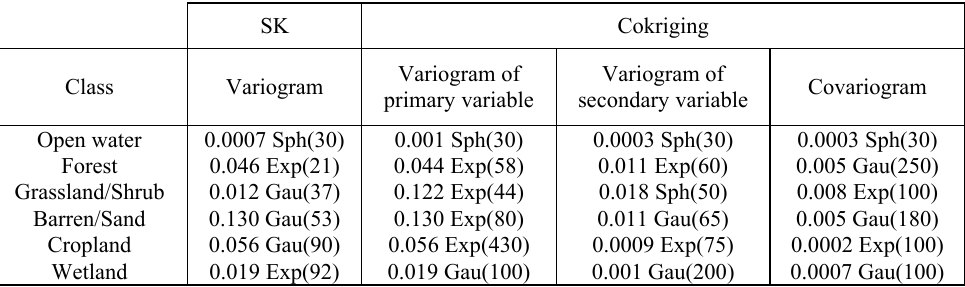
Table 1. Variograms and covariograms of SK and cokriging